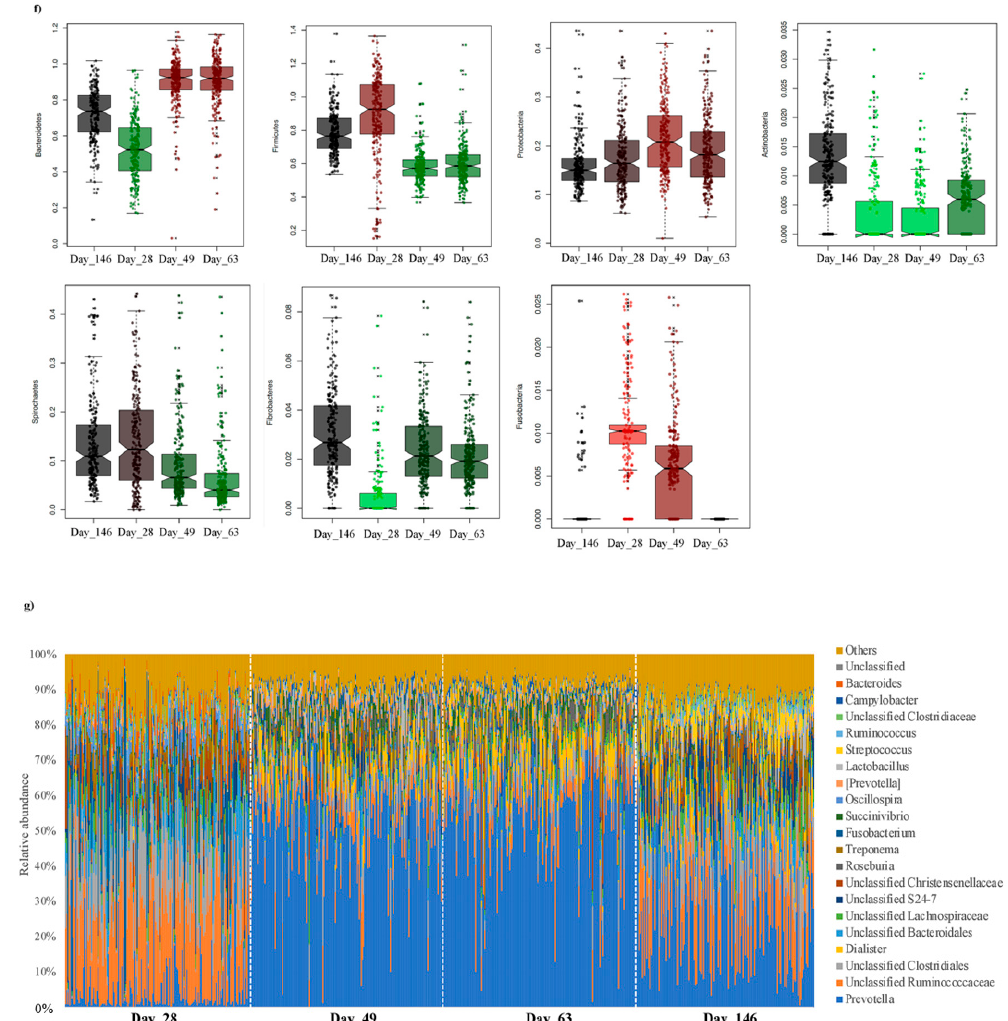
Figure 2. Longitudinal changes in microbial diversity and relative abundance. ( a ) Alpha diversity the differences *** p < 0.0001 ; see Table S1 ) , ( b ); unweighted UniFrac distance (Anosim p = 0.001 ) , ( c ); ( c ) Weighted UniFrac distance (Anosim p = 0.001), ( d ) Box plot representing the values of the